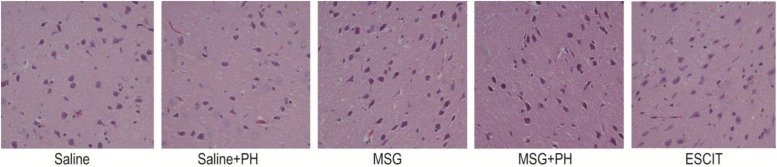
Effect of escitalopram on OFC histological features in MSG + PH-treated neonatal rats. Sections were stained using H&E. Magnification, 400×.